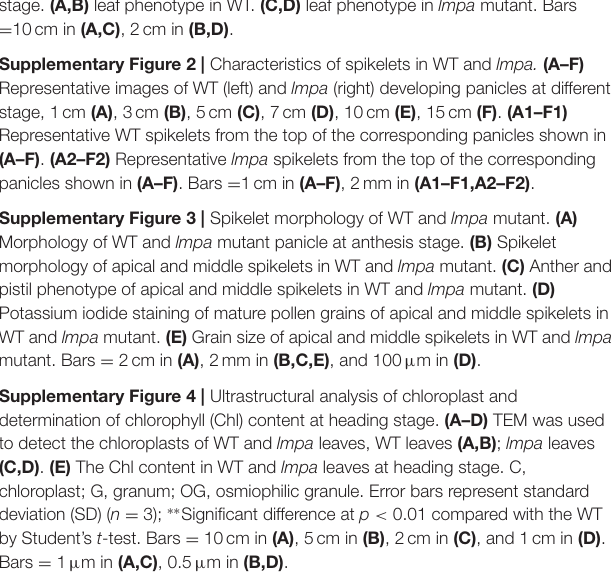
Supplementary Figure 1 | Leaf phenotype of WT and lmpa mutant at seeding stage. (A,B) leaf phenotype in WT. (C,D) leaf phenotype in lmpa mutant. Bars = 10cm in (A,C) , 2cm in (B,D) . Supplementary Figure 2 | Characteristics of spikelets in WT and lmpa. (A–F) Representative images of WT (left) and lmpa (right) developing panicles at different stage, 1cm (A) , 3cm (B) , 5cm (C) , 7cm (D) , 10cm (E) , 15cm (F) . (A1–F1) Representative WT spikelets from the top of the corresponding panicles shown in (A–F) . (A2–F2) Representative lmpa spikelets from the top of the corresponding panicles shown in (A–F) . Bars = 1cm in (A–F) , 2mm in (A1–F1,A2–F2) . Supplementary Figure 3 | Spikelet morphology of WT and lmpa mutant. (A) Morphology of WT and lmpa mutant panicle at anthesis stage. (B) Spikelet morphology of apical and middle spikelets in WT and lmpa mutant. (C) Anther and pistil phenotype of apical and middle spikelets in WT and lmpa mutant. (D) Potassium iodide staining of mature pollen grains of apical and middle spikelets in WT and lmpa mutant. (E) Grain size of apical and middle spikelets in WT and lmpa mutant. Bars = 2cm in (A) , 2mm in (B,C,E) , and 100 µ m in (D) . Supplementary Figure 4 | Ultrastructural analysis of chloroplast and determination of chlorophyll (Chl) content at heading stage. (A–D) TEM was used to detect the chloroplasts of WT and lmpa leaves, WT leaves (A,B) ; lmpa leaves (C,D) . (E) The Chl content in WT and lmpa leaves at heading stage. C, chloroplast; G, granum; OG, osmiophilic granule. Error bars represent standard deviation (SD) ( n = 3); ∗∗ Significant difference at p < 0.01 compared with the WT by Student’s t -test. Bars = 10cm in (A) , 5cm in (B) , 2cm in (C) , and 1cm in (D) . Bars = 1 µ m in (A,C) , 0.5 µ m in (B,D)